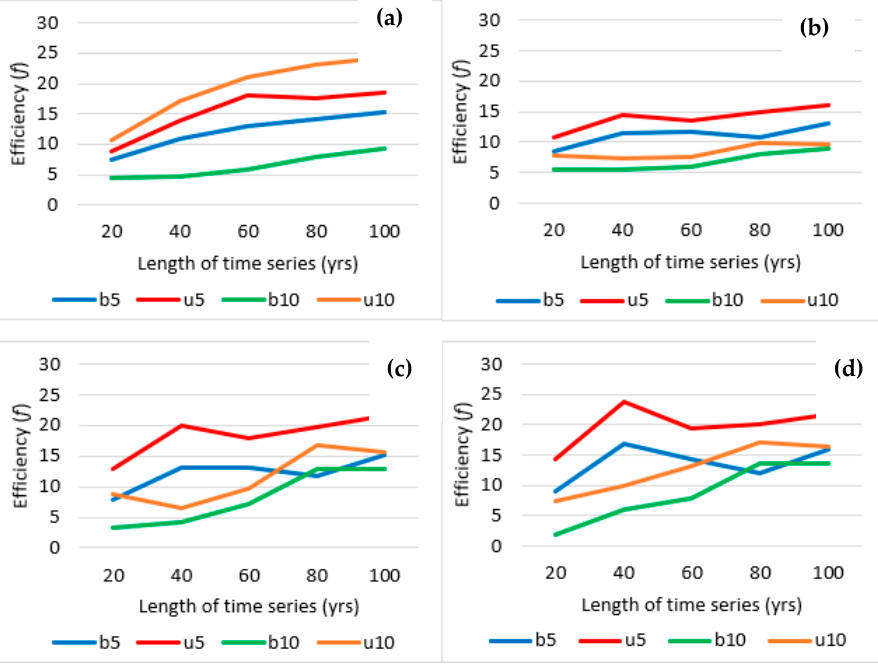
Figure 5. The same as Figure 4, but here the efficiencies are shown in the function of the length of time series. Upper left panel ( a ) CRMSEm, upper right panel ( b ) CRMSEy, bottom left panel ( c ) Trend bias for individual time series (Trbias), bottom right panel ( d ) Network mean trend bias (Trnetb).